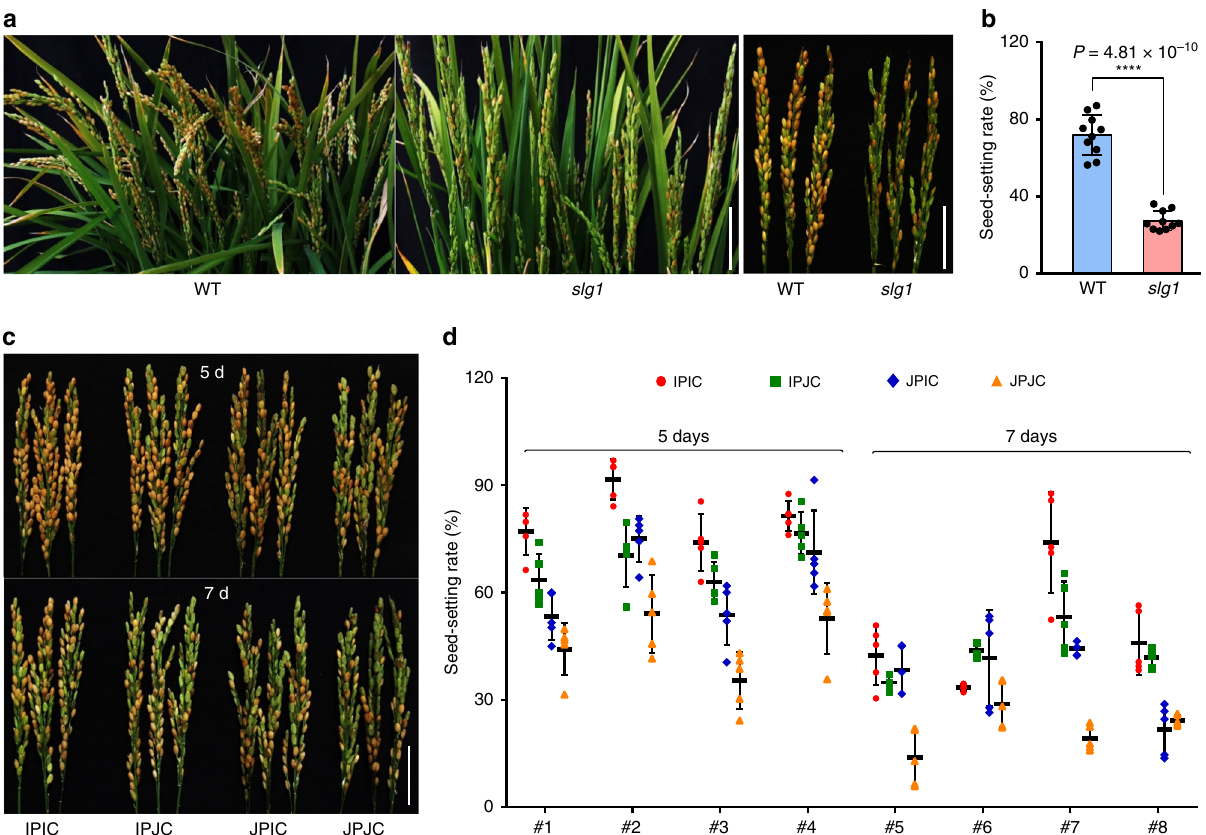
Fig. 6 SLG1 Ind enhances thermotolerance at the reproductive stage. a , b The slg1 mutant is highly sensitive to high temperature at the reproductive stage. Seed-setting rate was determined after treatment under 14 h light (40 °C)/10 h dark (31 °C) for 5 days, and recovered under normal conditions until seed maturation. Data are means± SD ( n = 10 panicles with three biological replicates). **** P < 0.0001, two-tailed Student ’ s t -test. Bar = 5 cm. c , d Comparison of thermotolerance among IPIC, IPJC, JPIC, and JPJC plants. Eight independent homozygous IPIC, IPJC, JPIC, and JPJC lines were treated with 14 h light (40 °C)/10 h dark (31 °C) for 5 days and 7 days, respectively, and then recovered under normal conditions until seed maturation. The x -axis indicates different transgenic lines. Data are means ± SD ( n = 5 panicles with three biological replicates). Bar = 5 cm. The source data underlying ( b ), ( d ) are provided as a Source data fi